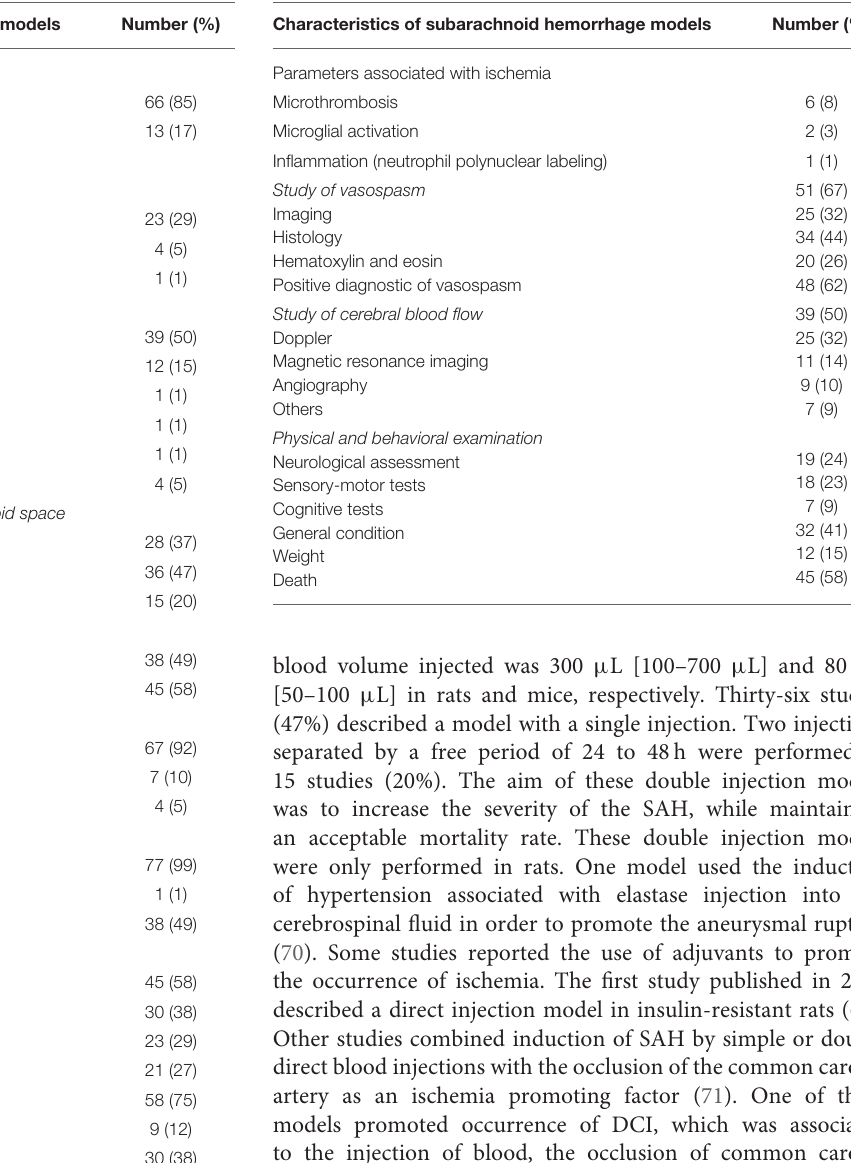
TABLE 1 | Characteristics of SAH